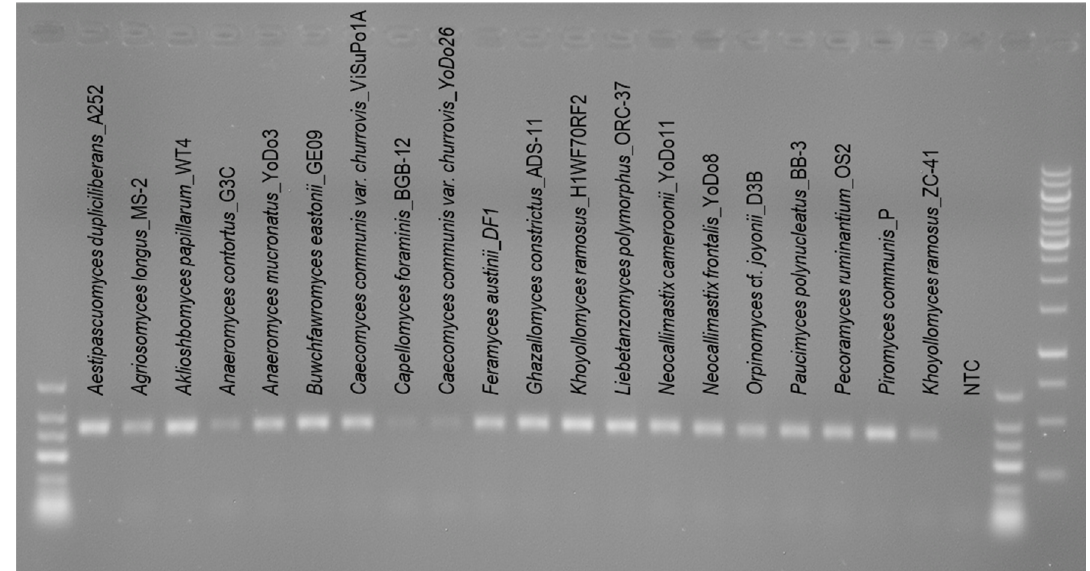
Figure 1. Agarose gel (1%) with amplicons of the D2 LSU subregion of 20 AGF isolates covering 18 AGF species. Amplicons, with an expected length of approximately 425 bp were generated with the AGF-LSU-EnvS-Illumina primers. GeneRuler TM Low Range DNA Ladder (ThermoFisher) on the left side, second and third bands 500 bp and 400 bp, respectively. GeneRuler TM 1 kb Ladder (ThermoFisher) on the far-right side, second to last bar 500 bp and last bar 250 bp. NTC = no template control.